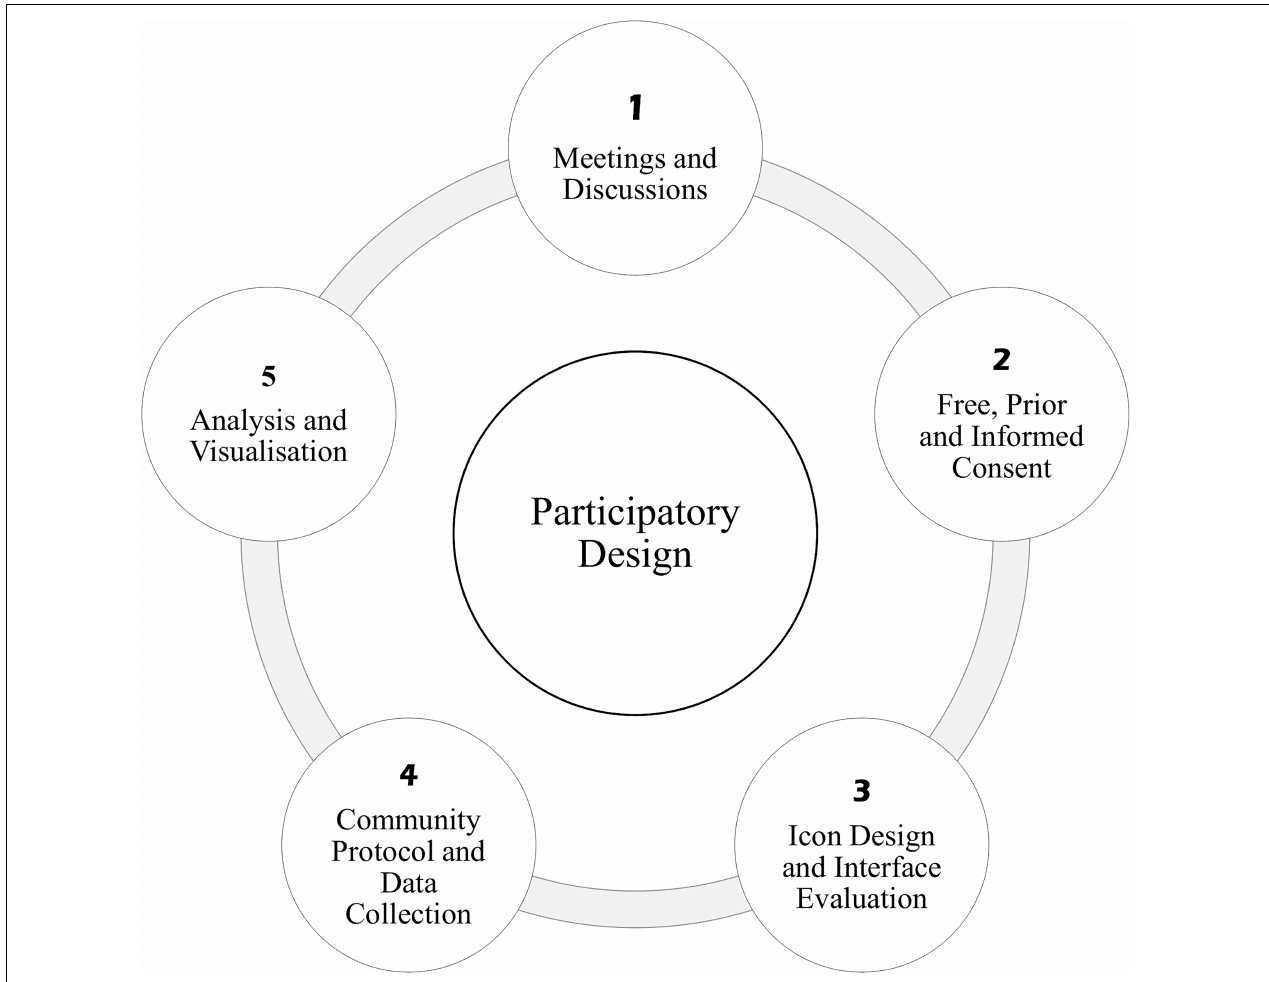
FIGURE 2 | Diagram of the different stages of ECS methodology relying on participatory